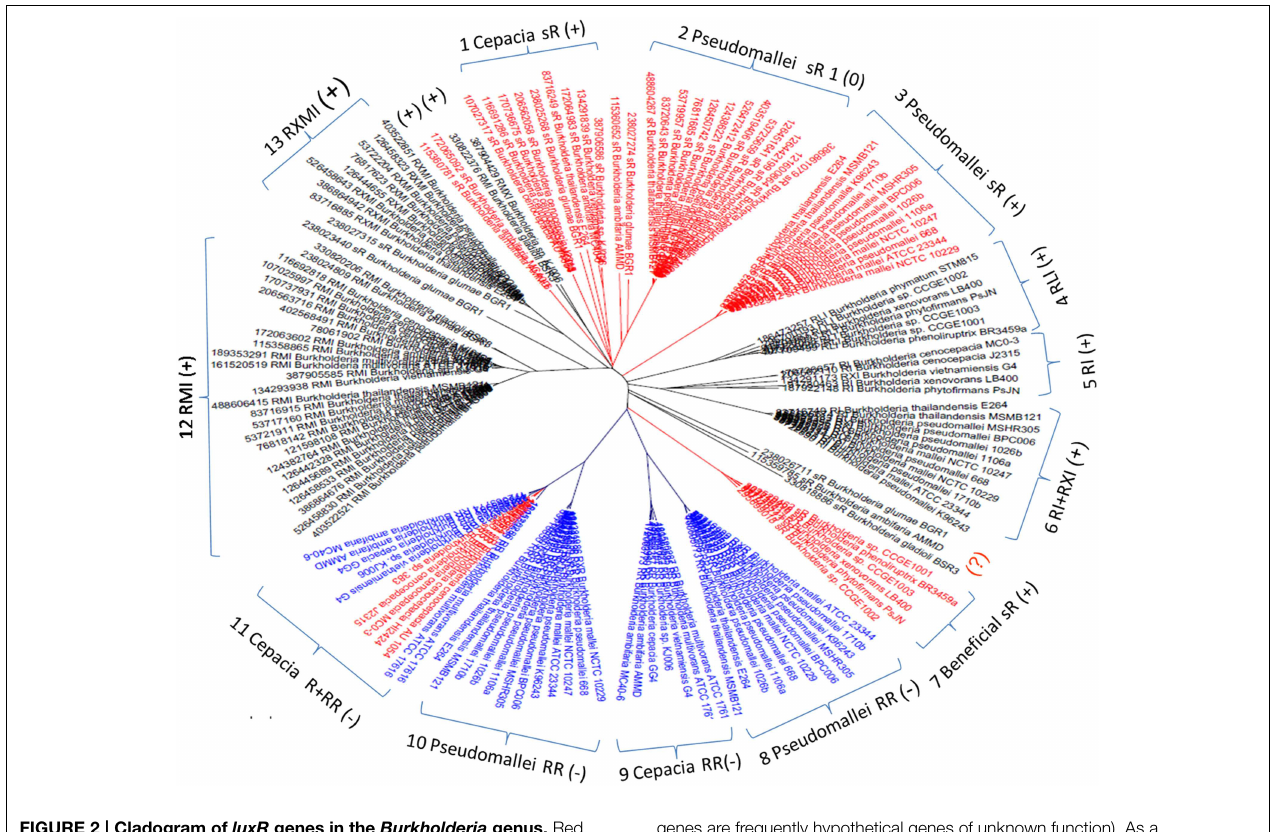
FIGURE 2 | Cladogram of luxR genes in the Burkholderia genus. Red, solo luxR s; Blue, solo luxR s in twin topology; Black, luxR genes in known QS circuits. ( + ) and ( − ) indicates clades where the AHL binding motives are present and absent respectively. In the tags, R stands for luxR , I for luxI , M is rsaM , L is rsaL and X stands for any other gene between luxR and luxI ( X